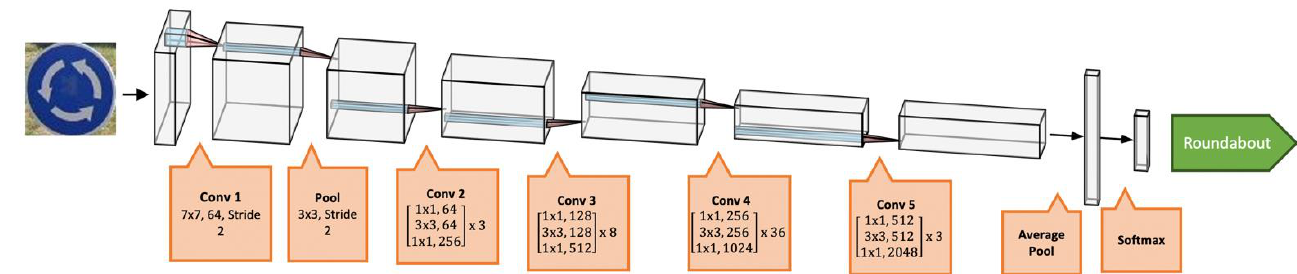
Figure 4. Schematic representation of the YOLOV3 architecture.